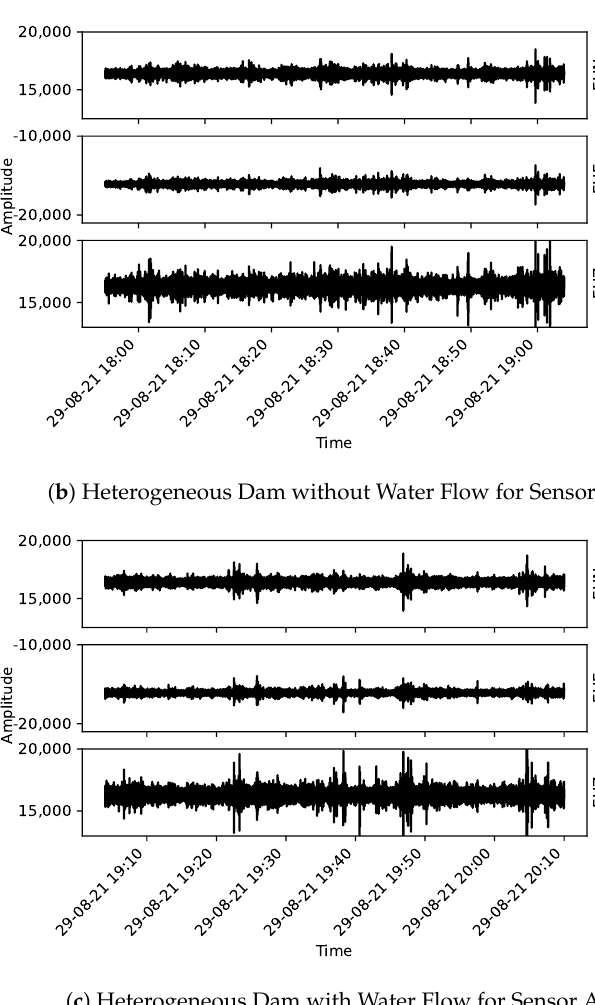
Figure 6. Collected data for sensor AM.R016A. From ( a ) to ( c ) the three monitoring stages are presented: homogeneous dam, heterogeneous dam without flow and heterogeneous dam with flow,